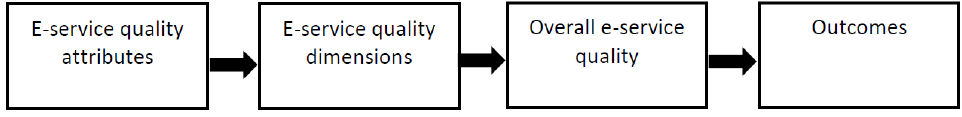
Figure 1. Conceptualization of e-service quality [36].